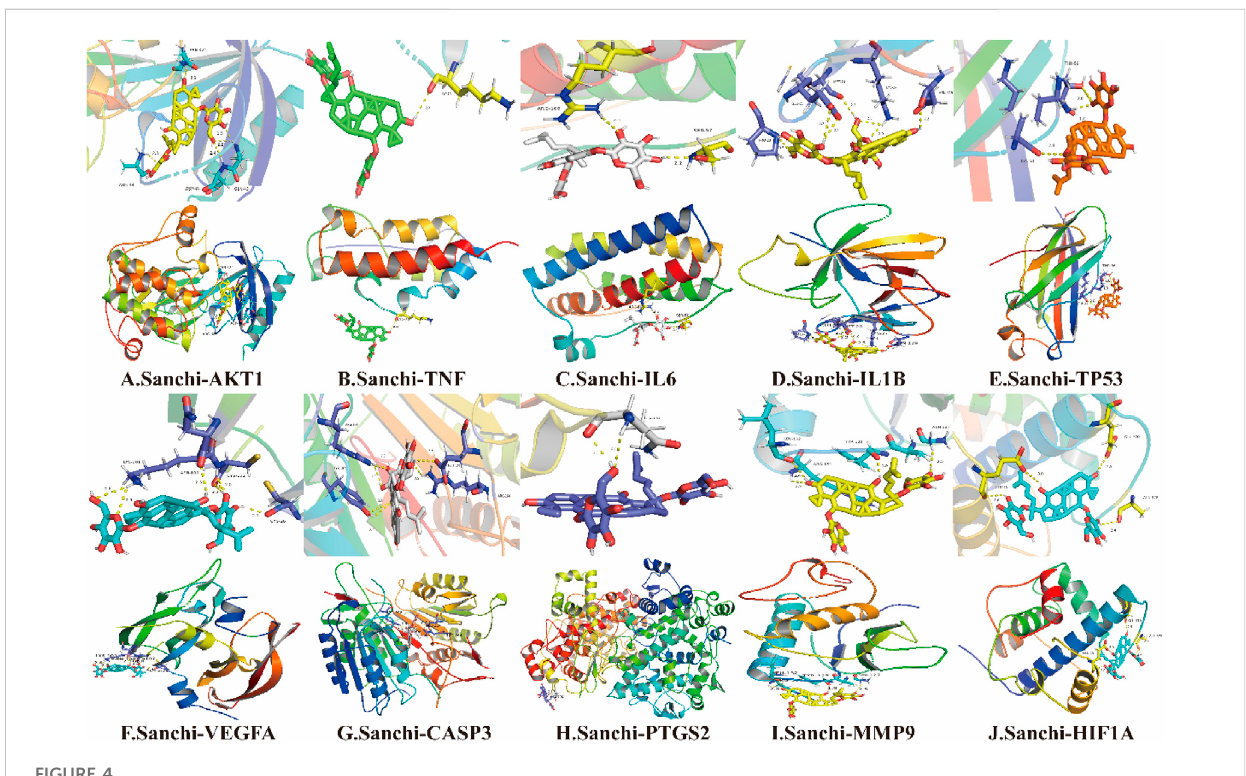
FIGURE 4 Molecular docking results of Sanchi and hub gene-related